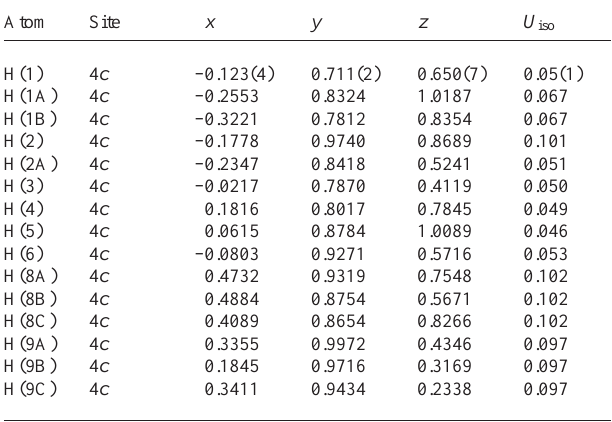
Table 2. Atomic coordinates and displacement parameters (in Å 2 )